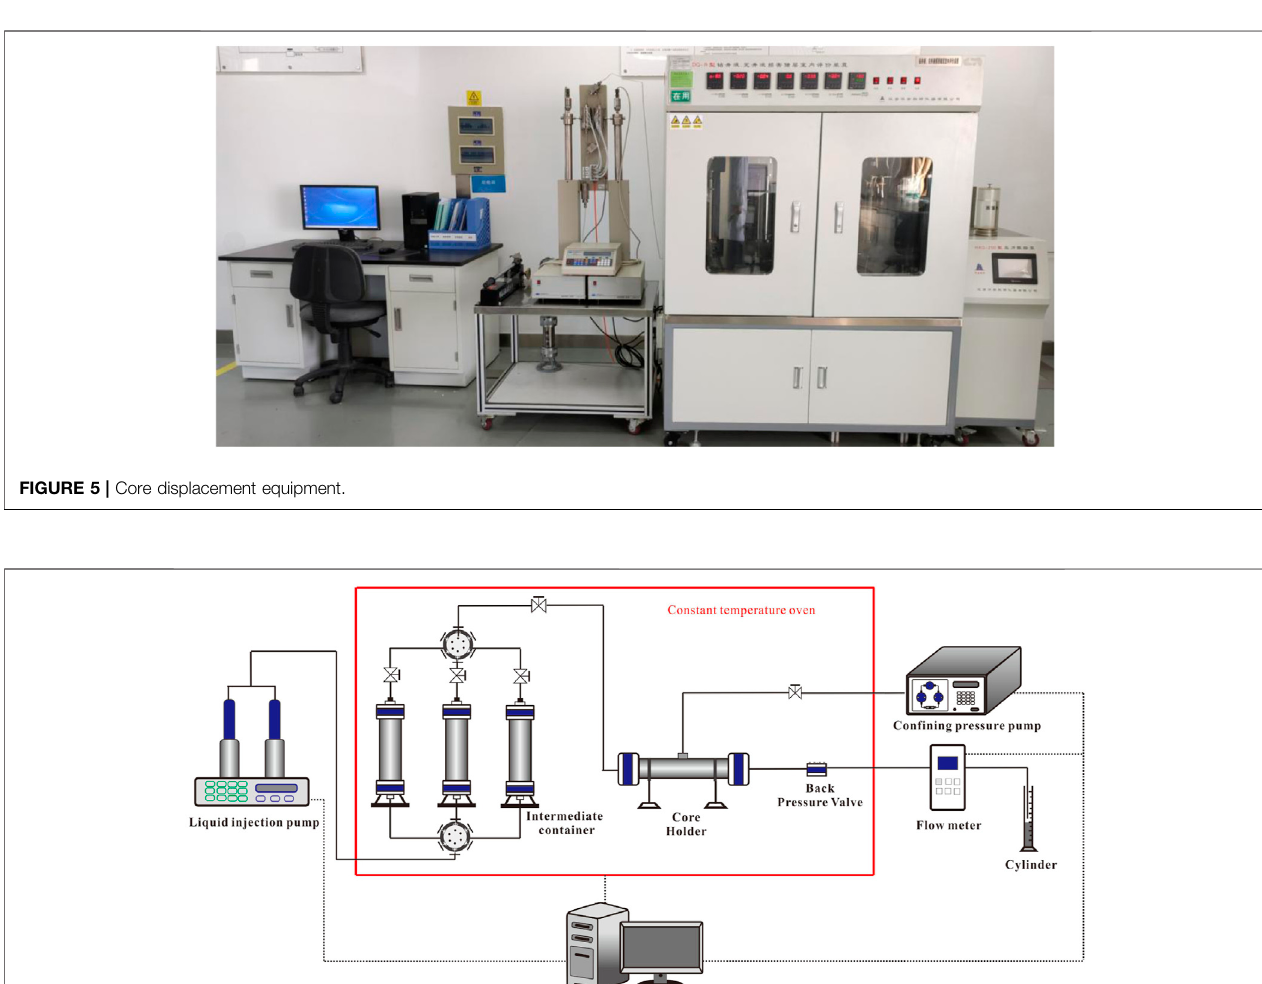
Frontiers in Energy Research |